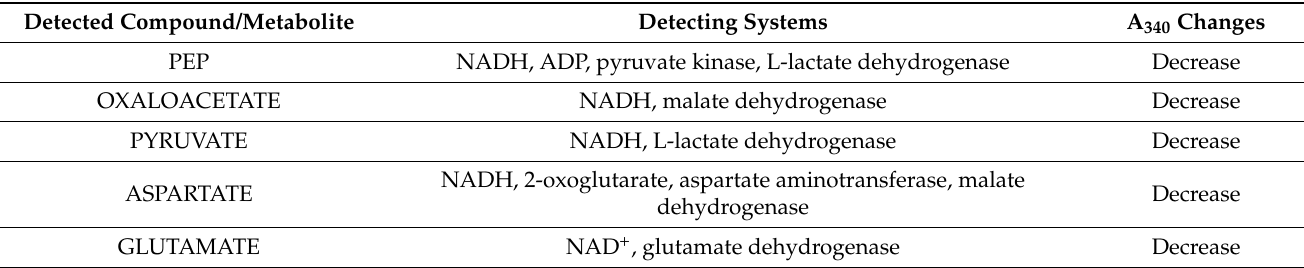
Table 2. The compound/metabolite detection outside